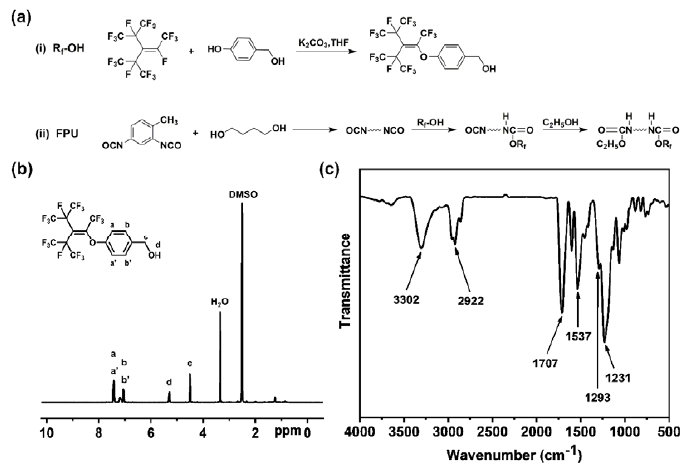
Figure 1. ( a ) Preparation procedure of ( i ) R f ‐ OH and ( ii ) FPU; ( b ) 1H ‐ NMR spectrum of R f ‐ OH in DMSO ‐ d6; ( c ) FTIR spectrum of FPU.